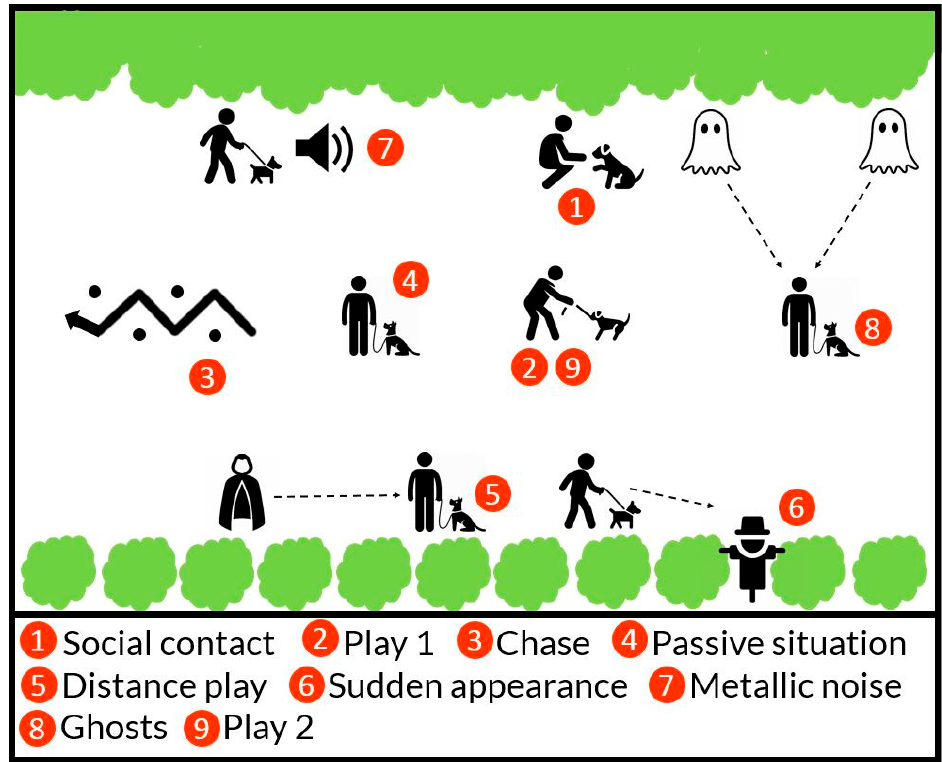
Figure 1. Overview of the outdoor testing area and the position of each subtest; (1) Social contact, (2) Play 1, (3) Chase, (4) Passive situation, (5) Distance play, (6) Sudden appearance, (7) Metallic noise, (8) Ghosts, (9) Play 2.